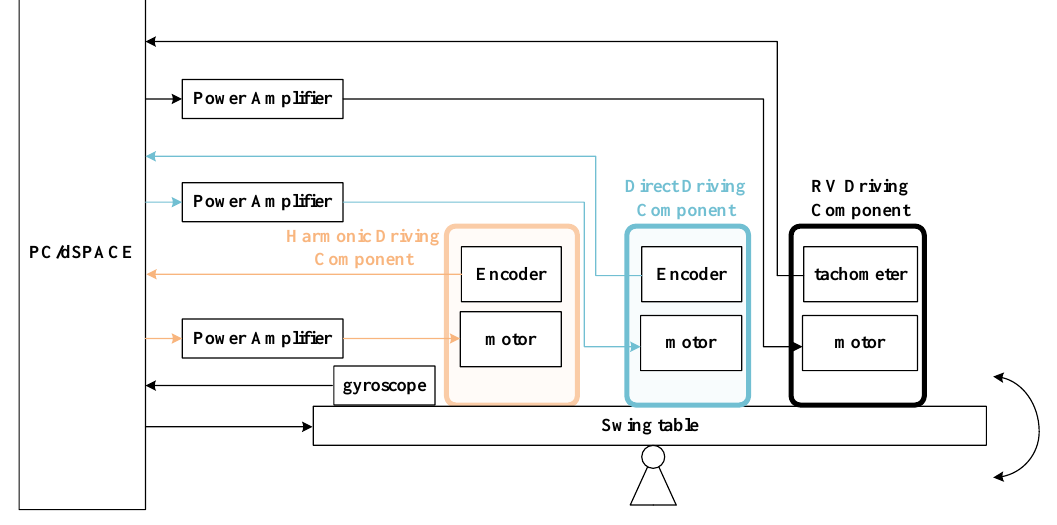
Figure 5. Block diagram of the experimental setup. Table 1. Main parameters of the experimental setup.